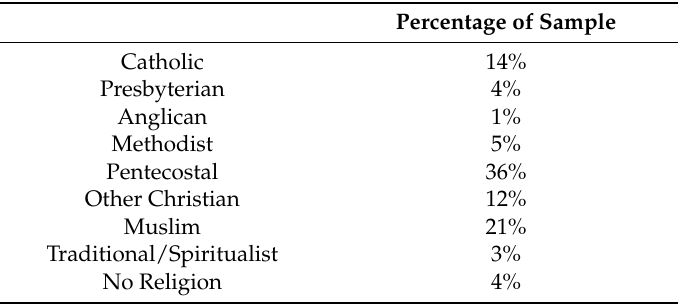
Table 1. Reported Religious Denomination in the